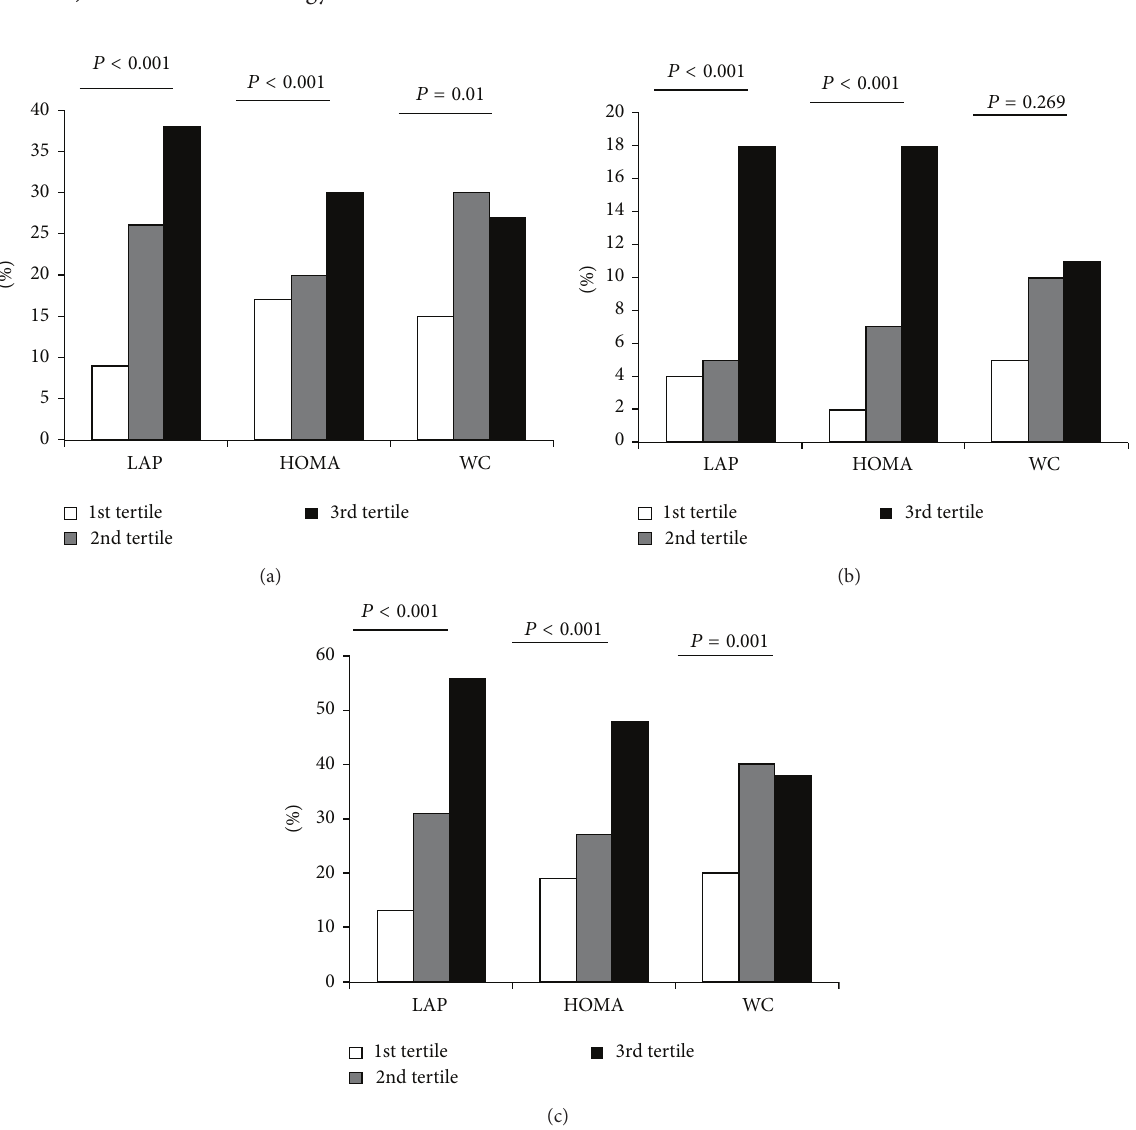
Figure 1: Prevalence of abnormalities in glucose metabolism by 2-hour postload glucose of an oral glucose tolerance test ( Plot (a), IGT; Plot (b), T2-DM; Plot (c), composite glucose tolerance conditions (IGT + T2-DM)) according to tertiles of waist circumference, LAP, and HOMA-IR in the whole study